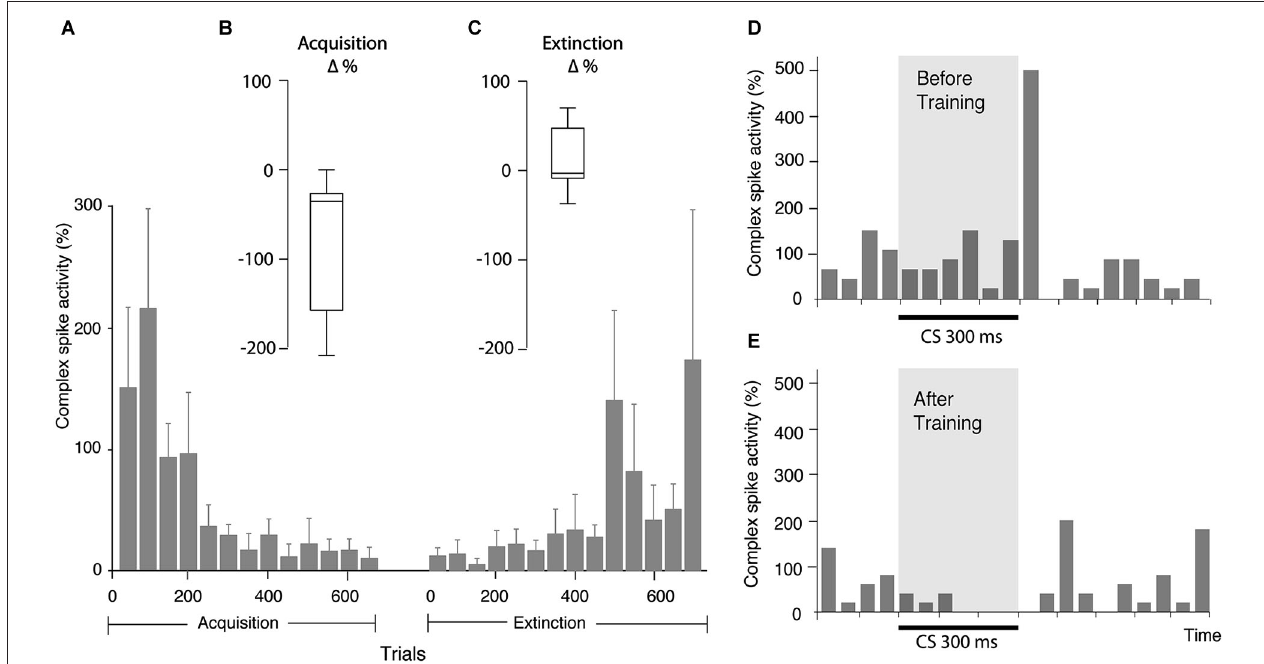
(B) Distribution of change in complex spike activity between the first 50 and last 50 trials of the acquisition phase ( n = 8). (C) Distribution of the change in complex spike activity between the first 50 and last 50 trials of the extinction phase ( n = 9). (D) Bar chart illustrating complex spike frequency in the first 100 trials in the acquisition phase. (E) Complex spike activity in the same cell in the first 100 trials in the extinction phase. Binsize is 50